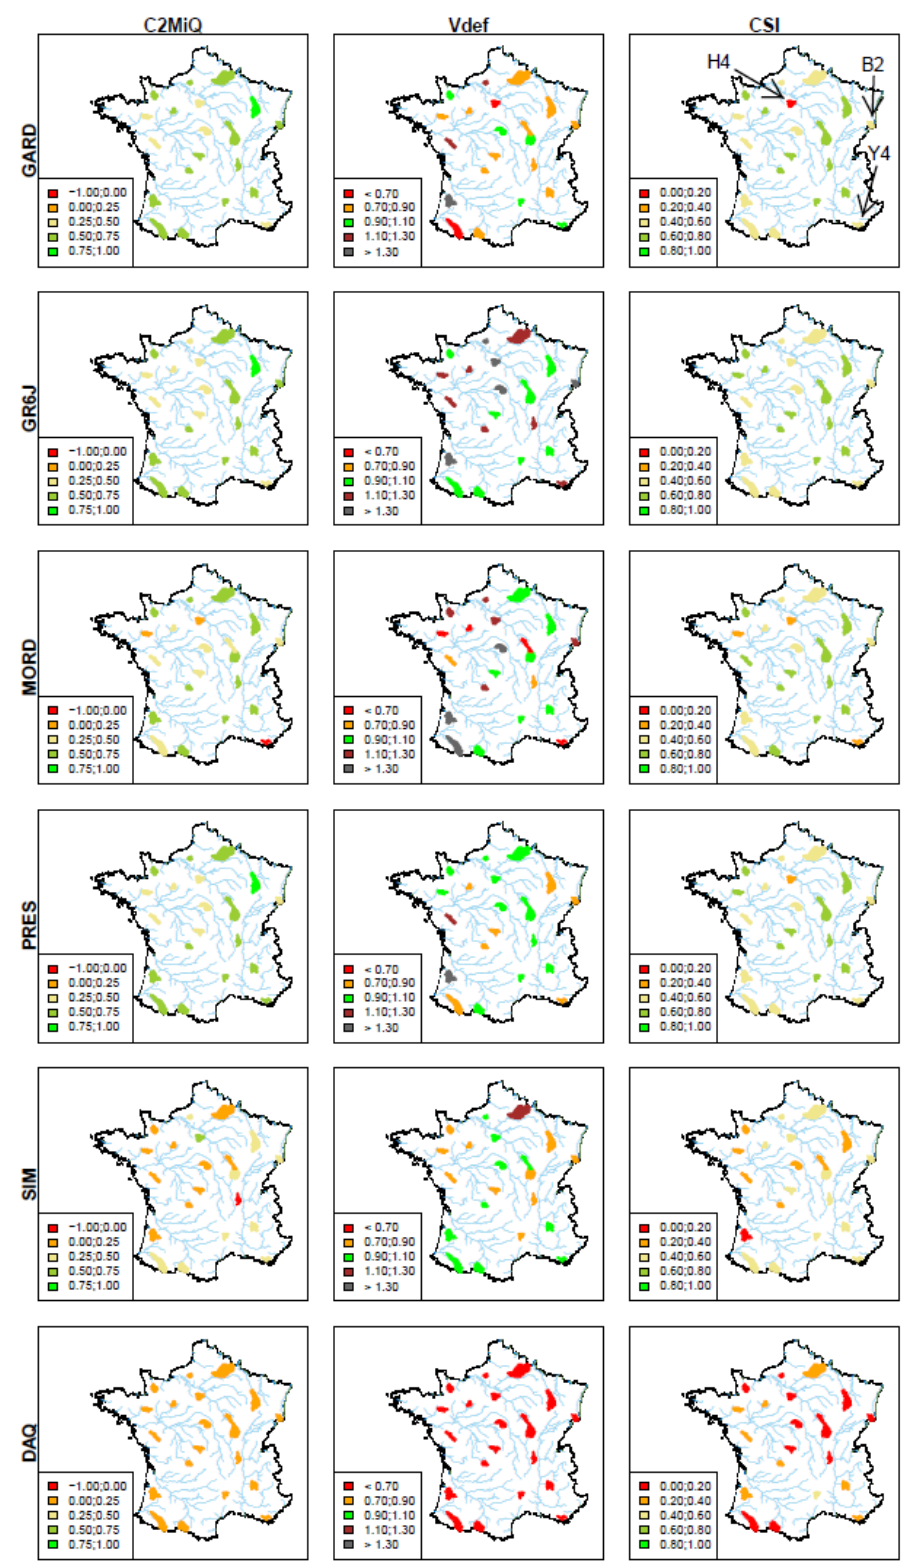
Figure 5. Maps of the mean performance on the two validation periods for the C2M, Vdef and CSI criteria, obtained by the five tested models and the benchmark (DAQ) on the 21 catchments, in simulation mode. The letters on the top right map show the catchments (fist two letters of the HYDRO code, see Table 1) whose results are commented in more detail in the text (B2: Meuse; H4: Orge: Y4: Gepeau). Hydrol. Earth Syst. Sci., 18, 2829–2857,